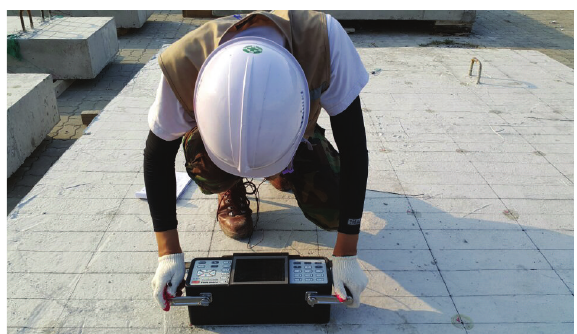
Figure 12: S-wave measurement in the grid on concrete slab surface.